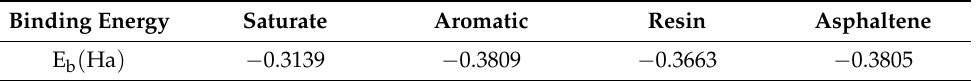
Table 7. The binding energy between each component molecule of asphalt and SBS molecule. Binding